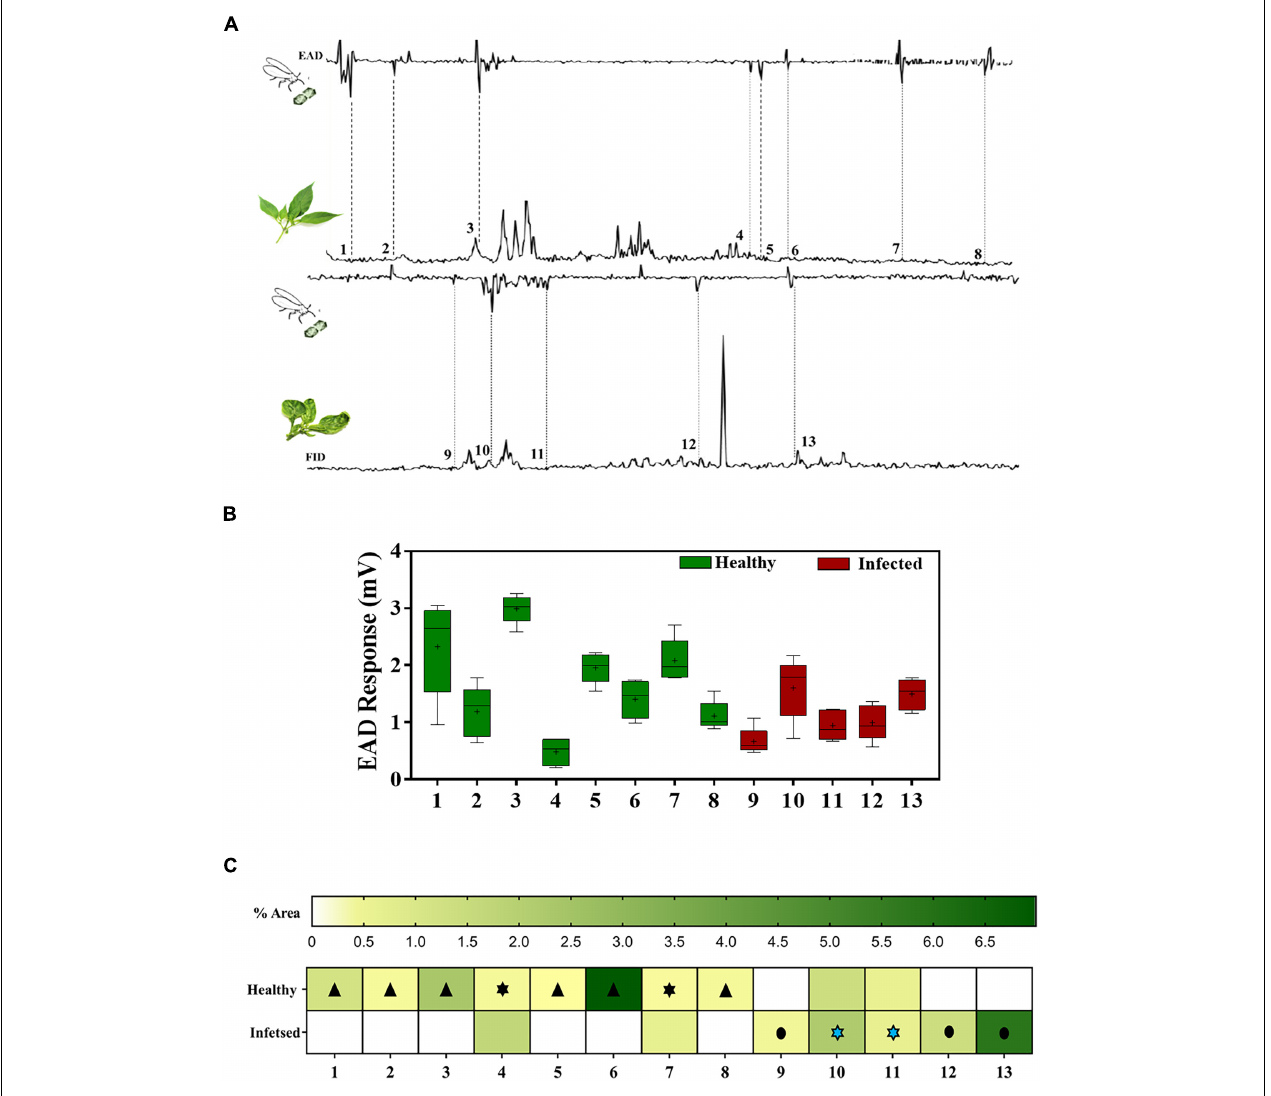
FIGURE 5 | Antennal response of viruliferous B. tabaci to healthy and infected chili volatiles. (A) Representative GC-EAD trace showing EAD active peaks. (B) Box and Whisker plot showing the compounds that elicited antennal response. (C) Heat map showing the differences in the volatile emissions of chili plants under different treatments. “ ” – indicates antennal response to compounds exclusively present in healthy plant volatiles; “ ” – indicates antennal response to compounds (with varied concentrations) from “healthy” and “infected” plant volatiles, respectively; “ ” – indicates the antennal response to compounds exclusively present in infected plant volatiles. Serial numbers in the x -axis of (A–C) correspond to EAD active chemical compounds and given here [1 2,3, Butanediol 2,3,dimethyl; 2 Butanoic acid, 2-ethyl-2- methyl-, methyl ester; 3. cis-3-Hexenyl isobutyrate; 4. 2-Hexyl-1-decanol; 5. 2-Methyl hexadecane; 6. Phytane; 7. Heptadecane 2, 6,10,15, tetramethyl; 8. n-Nonadecane; 9. Limonene; 10. 1-octanol- 3,7 dimethyl; 11. Ethyl benzaldehyde; 12. cis-Geranyl acetate; 13. 2 octenol-1-ol 3,7 dimethyl isobutyrate (Z)].